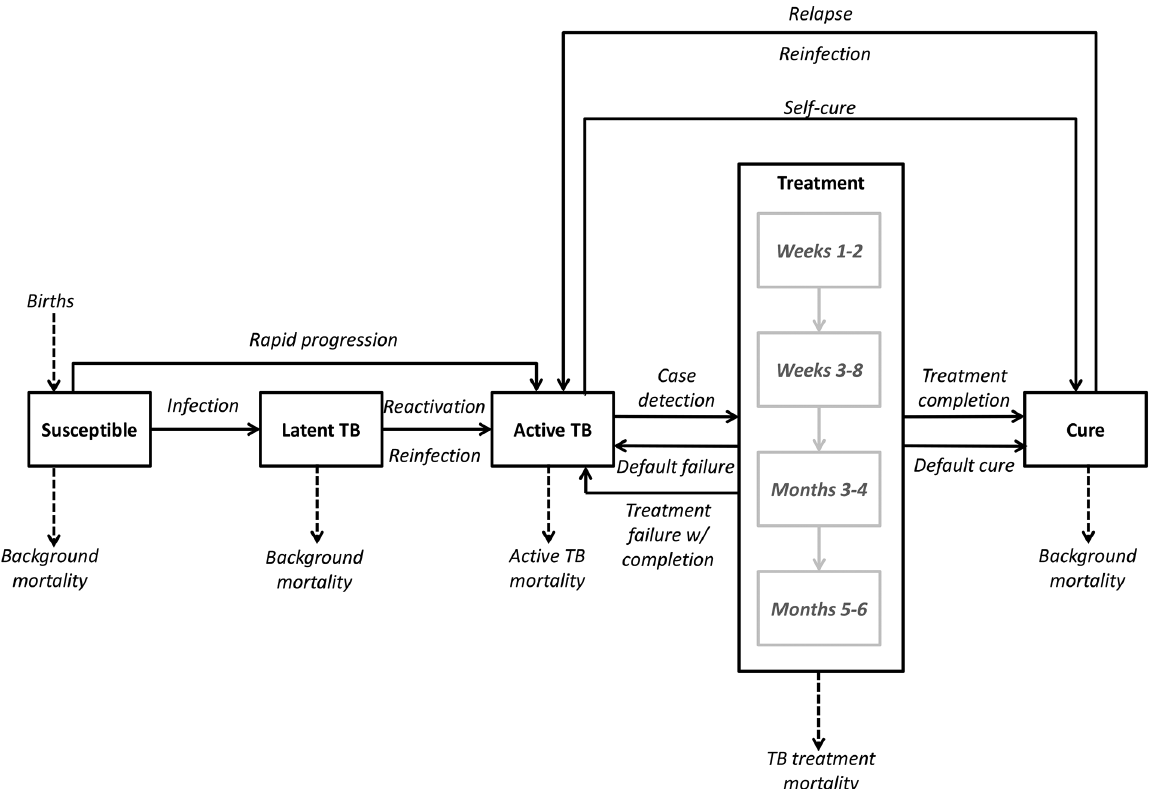
Figure 1. Model compartments and transition rates. Boxes represent the proportions of the modeled population that are susceptible to infection, latently infected with M. tuberculosis , in active TB disease, under treatment, or cured. Arrows represent the transitions between various states, including up to four sequential phases of treatment. Rates of transition are described in the Methods section and Appendix S1.